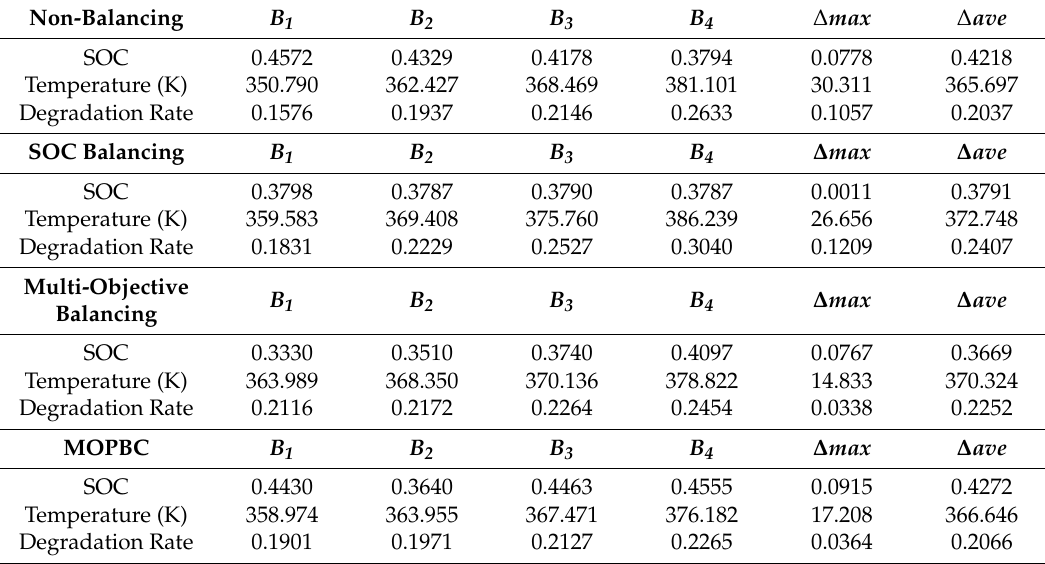
Table 2. The simulation results